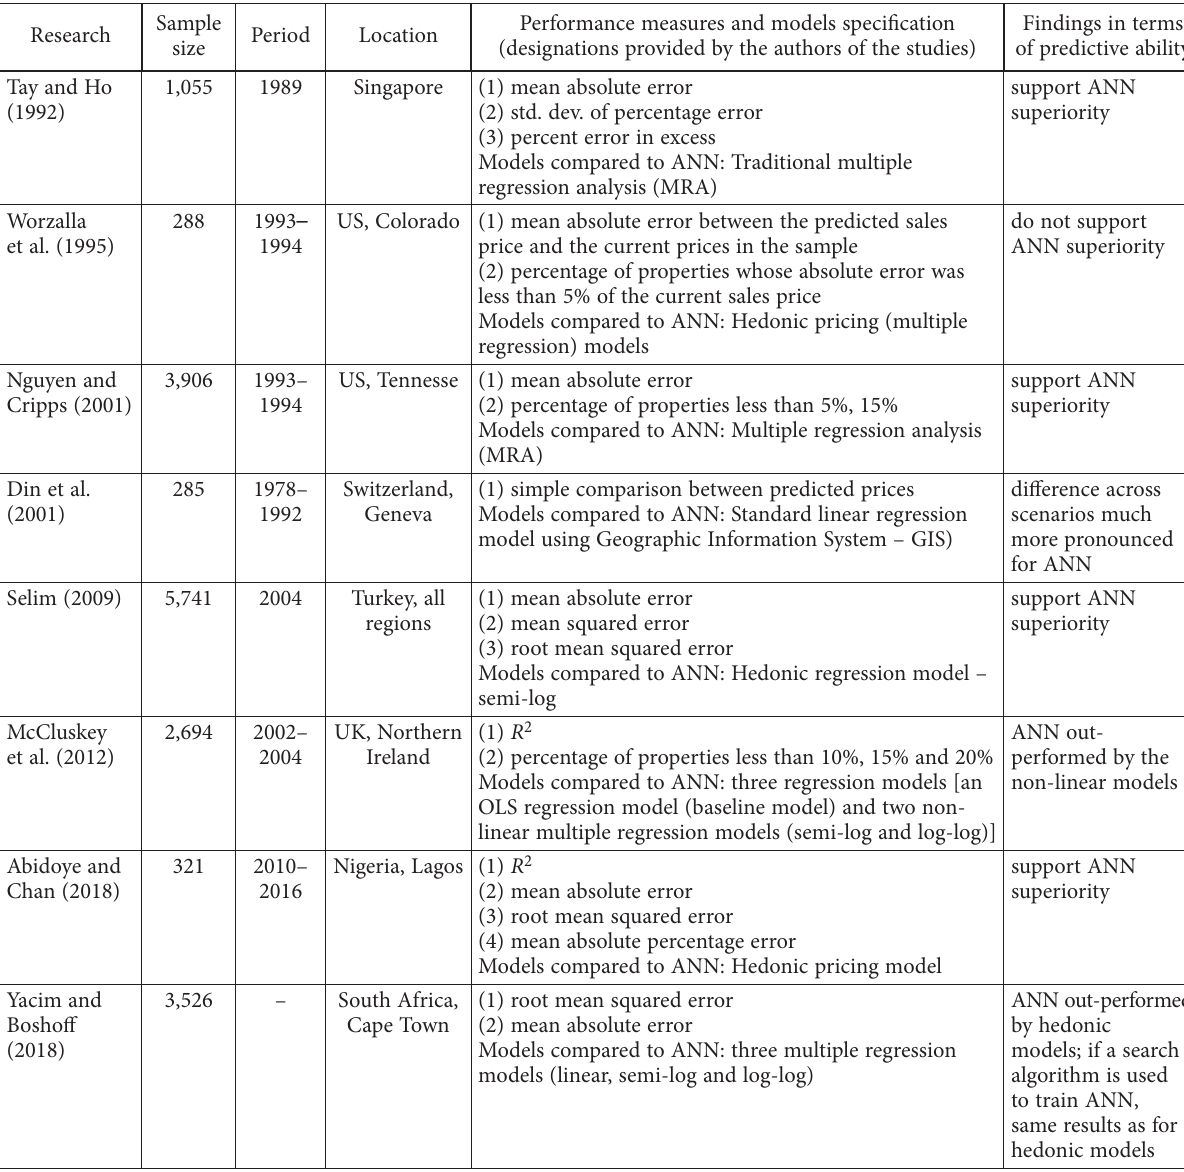
Table 2. Description, methodology and findings of the selected studies in terms of ANN versus MRA models predictive ability Research